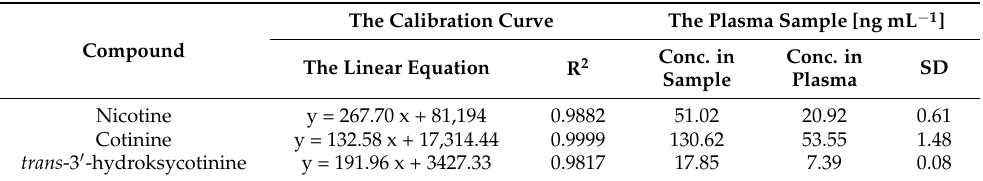
Table 3. The standard additions calibration method for the determination of nicotine and its major metabolites in plasma of tobacco